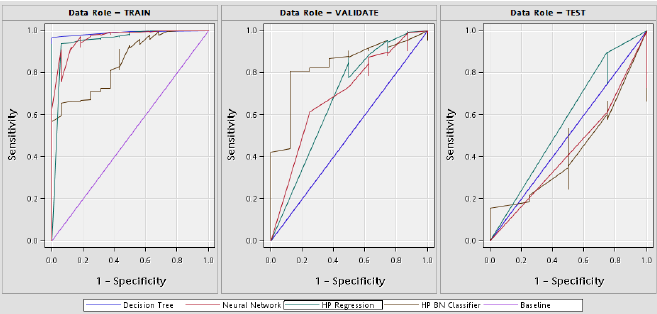
Figure 6. ROC curve comparison results.